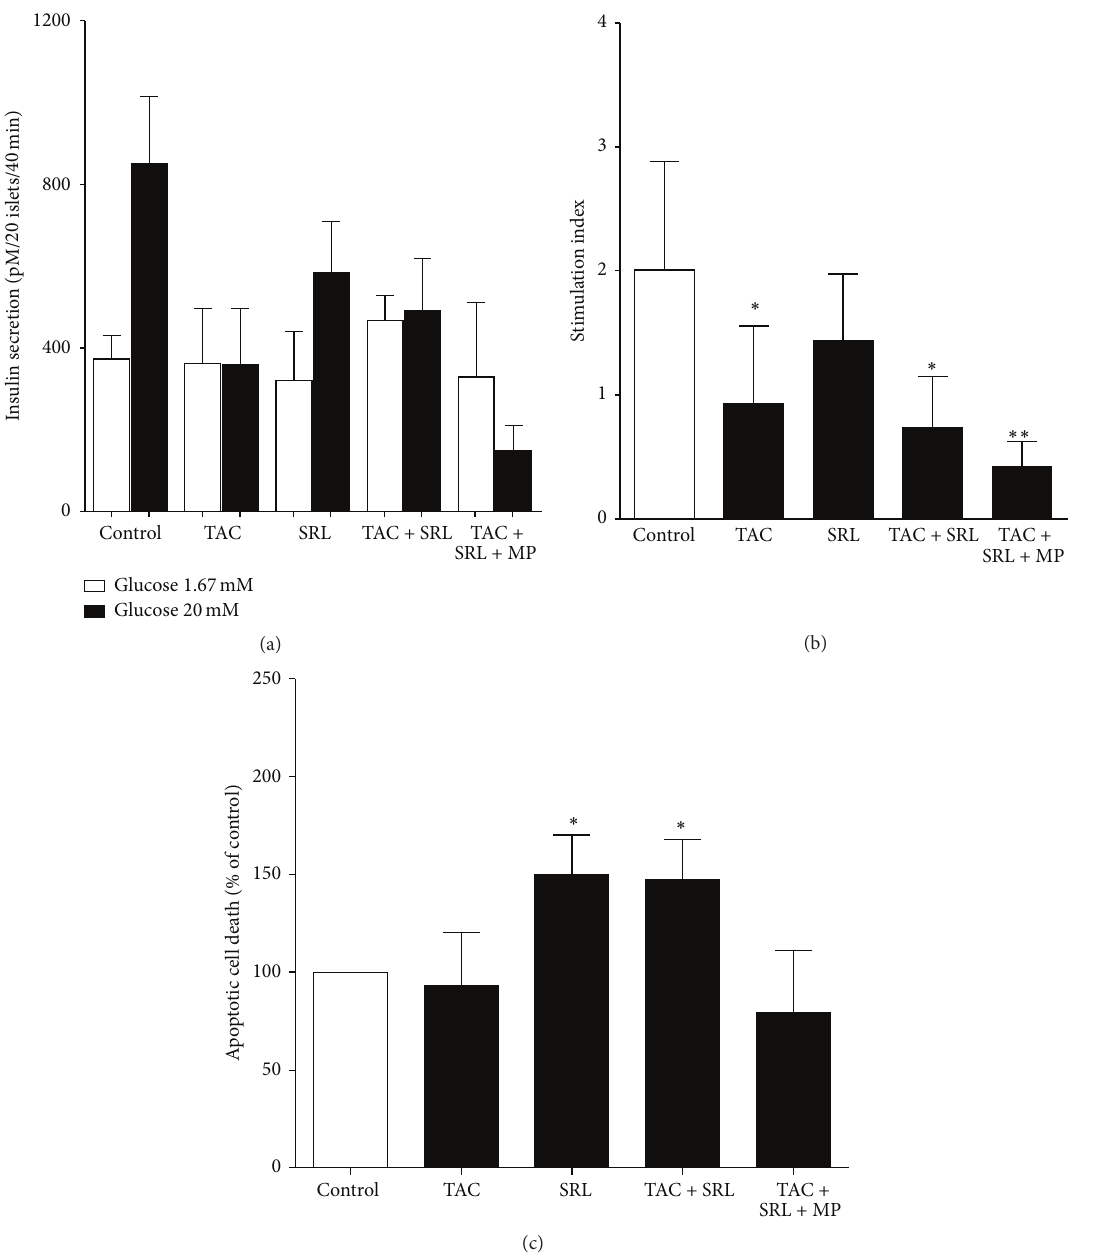
Figure 1: The effect of immunosuppressant drugs on human islets function and survival. Human islets treated without or with tacrolimus (TAC 30 𝜇 g/L), sirolimus (SRL 30 𝜇 g/L), or a combination thereof with or without methylprednisolone (MP 100ng/L) for 24 h. (a) Glucose- stimulated insulin secretion (GSIS) and (b) corresponding stimulation index (SI) (ratio stimulated to basal glucose-stimulated insulin secretion) in human islets as described in Section 2. (c) Apoptotic cell death measured by the Cell Death Detection ELISA PLUS in human islet following the same culture conditions. Data are presented as means ± SEM of five separate experiments from five different donors. ∗ 𝑝 < 0.05 , ∗∗ 𝑝 < 0.006 versus